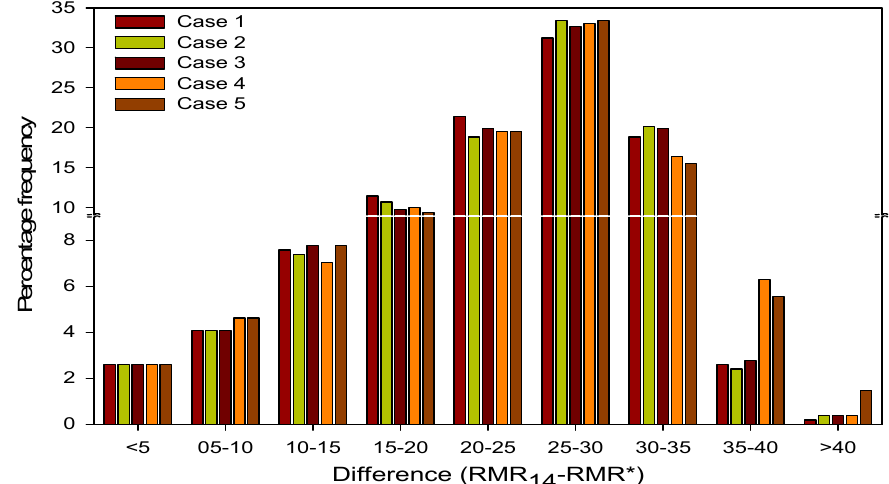
Figure 3. Effect of weightage (Table 6) during back-calculation of rock-mass quality ( RMR *) (Figure 1) in terms of difference between stress-adjusted RMR 89 ( RMR 89 *) and RMR * using hypothesis of Table 3.